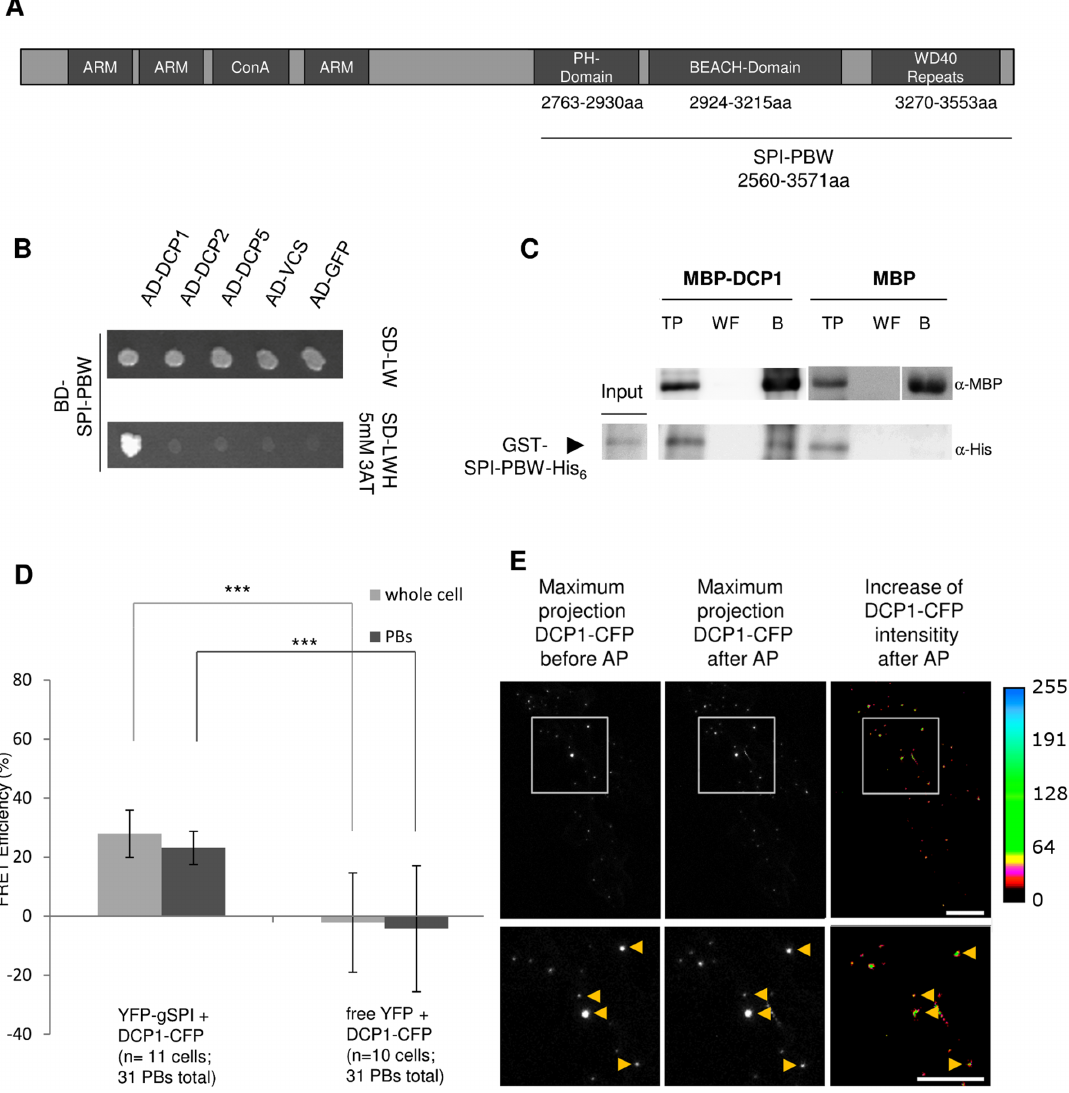
Fig 1. The SPI protein interacts with DCP1. (A) Schematic presentation of the domain organization of the SPI protein: the ARMADILLO repeats (ARM), the Concanavalin A-like lectin domain (ConA), and the C-terminal PBW module (SPI-PBW). (B) Yeast two-hybrid interactions. Upper part: double transformed yeast cells on selective dropout medium lacking leucine (-L) and tryptophan (-W). Bottom part: interaction between SPI-PBW, N-terminally fused to the GAL4 Binding Domain (BD), and DCP1 and other P-body core components fused to the GAL4 Activation Domain (AD), on selective dropout medium lacking leucine (-L), tryptophan (-W), and histidine (-H), supplemented with 5 mM 3-Aminotrizole (3AT). The Green Fluorescent Protein (GFP), N-terminally fused to the GAL4-AD, has been included as negative control. (C) Coprecipitation of SPI-PBW-His 6 with DCP1-MBP. Throughputs (TP), wash fractions (WF), and resin-bound MBP fusions (B) were detected by α -MBP (upper part) and α -His 6 (lower part) antibody staining. GST-SPI-PBW-His 6 (~110 kDa, arrowhead) coprecipitated with MBP-DCP1 (~ 83 kDa), but not with MBP (~42 kDa). Samples detected on different blots are separated by lines. (D) FRET E (in %) was measured in whole leaf epidermis cells (whole cells) and stationary P-bodies (PBs). YFP was bleached in whole cells (for details see Materials and Methods). Mean FRET E ’ s for 35S pro :YFP-gSPI and 35S pro :DCP1-CFP (n = 11 cells) or 35S pro :YFP and 35S pro :DCP1-CFP (n = 10 cells) are shown. Error bars represent standard deviations for whole cells, and the standard deviation of the mean for PBs ( n = 31 stationary PBs derived from whole cell samples). Two- tailed student ’ s t test was performed to compare FRET E between 35S pro :YFP-gSPI/35S pro :DCP1-CFP and 35S pro :YFP/35S pro :DCP1-CFP for each group ( *** p < 0.001). (E) Representative images of 35S pro :DCP1-CFP in a transiently transfected leaf epidermis cell prior to (left) and after (middle) Acceptor- photobleaching (AP). For a better visualization, the increase of fluorescence intensity of DCP1-CFP after AP is presented in pseudocolors (right), see color scale for comparison. A group of stationary PBs is highlighted by the boxed area and magnified (lower row). Yellow arrowheads in magnifications mark stationary PBs used for FRET quantifications. Scale bars: 30 μ m.